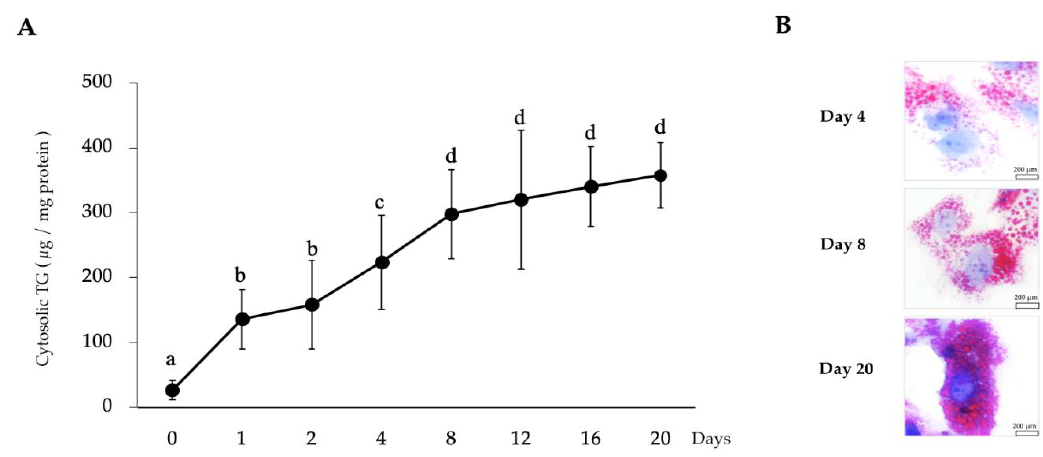
Figure 1. Long-term adipogenic differentiation mediated fat accumulation into the porcine intramuscular preadipocyte (PIP) in vitro culture. The PIP cells (2.5 × 10 4 /cm 2 ) were kept in vitro culture for 20 days with differentiation medium, and cells were harvested at different time points to estimate the degree of cytosolic fat accumulation by using a triglyceride (TG) assay kit ( A ). Data shown are the mean ± SD of three independent experiments performed in triplicates. Different letters (a, b, c, and d) labeled upon the time points indicate significant differences ( p < 0.05), while the same letter indicates no significant difference between the contrast pairs. Oil red O staining of adipocytes demonstrated the fat droplets red color while the nucleus takes a blue color when observed under microscope ( B ).